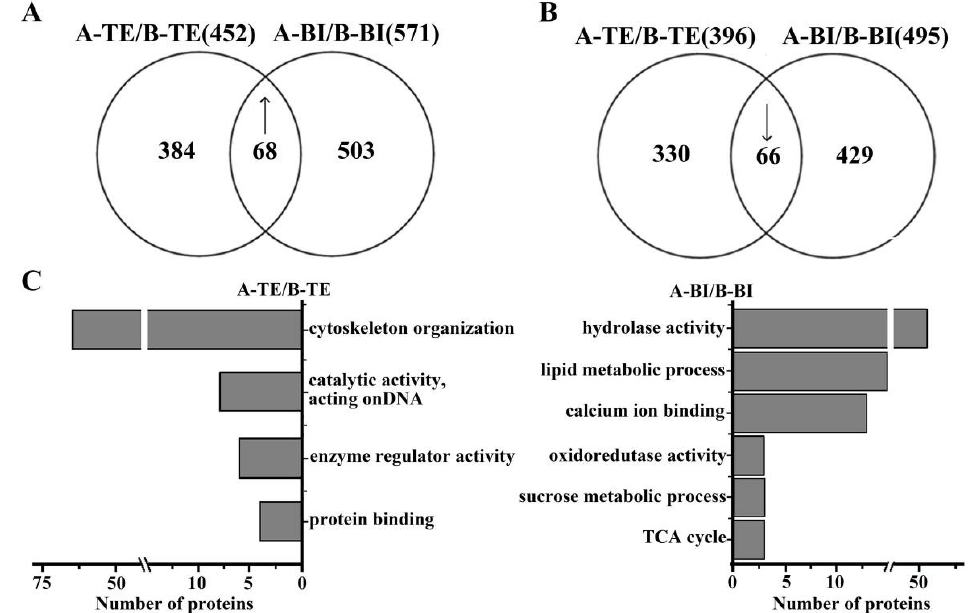
Figure 4. Functional distribution of DAPs in male sterile line 09-05A and its maintainer line 09-05B of B. juncea . Flower buds of B. juncea were collected at the TE and BI stages. Proteins were extracted, reduced, alkylated, digested, and analyzed by nanoLC-MS/MS. Proteins in flower buds of 09-05A were compared with those in 09-05B at the TE and BI stages, respectively. “ ↑ ” represents upregulation; “ ↓ ” represents downregulation. ( A ) Comparison of up-accumulated DAPs identified in 09-05A/09-05B. ( B ) Comparison of down-accumulated DAPs identified in 09-05A/09-05B. ( C ) Predicated and categorized functions of DAPs.